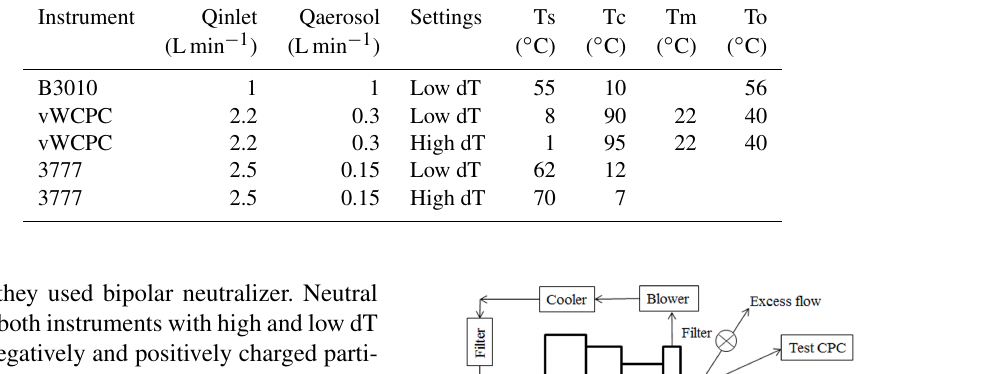
Table 1. Instrument operation conditions. Instrument Qinlet Qaerosol Settings